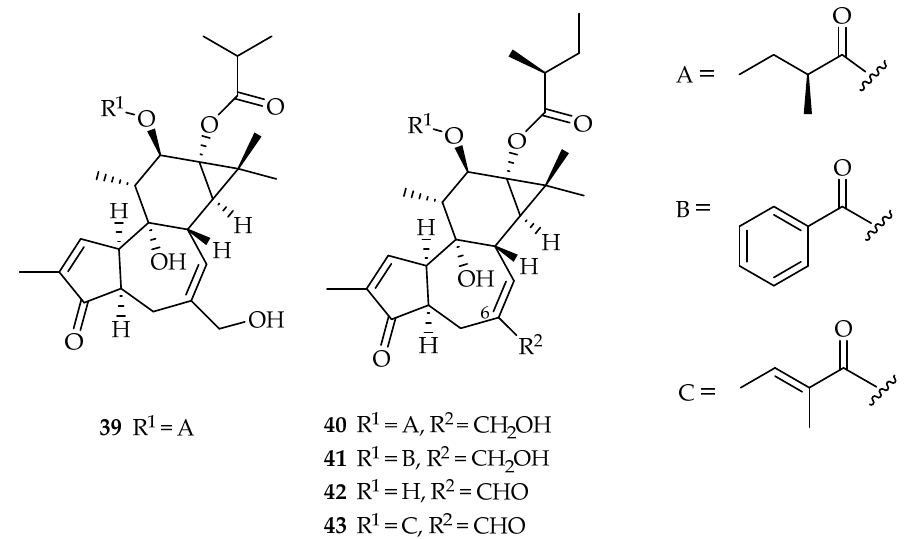
Figure 17. Structures of crodamoid A 39 , crodamoid C 40 , crodamoid D 41 , crodamoid H 42 , and crodamoid I 43 [28].